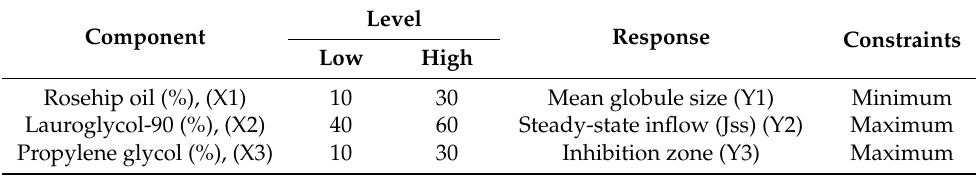
Table 2. Experimental mixture design (component levels and selected